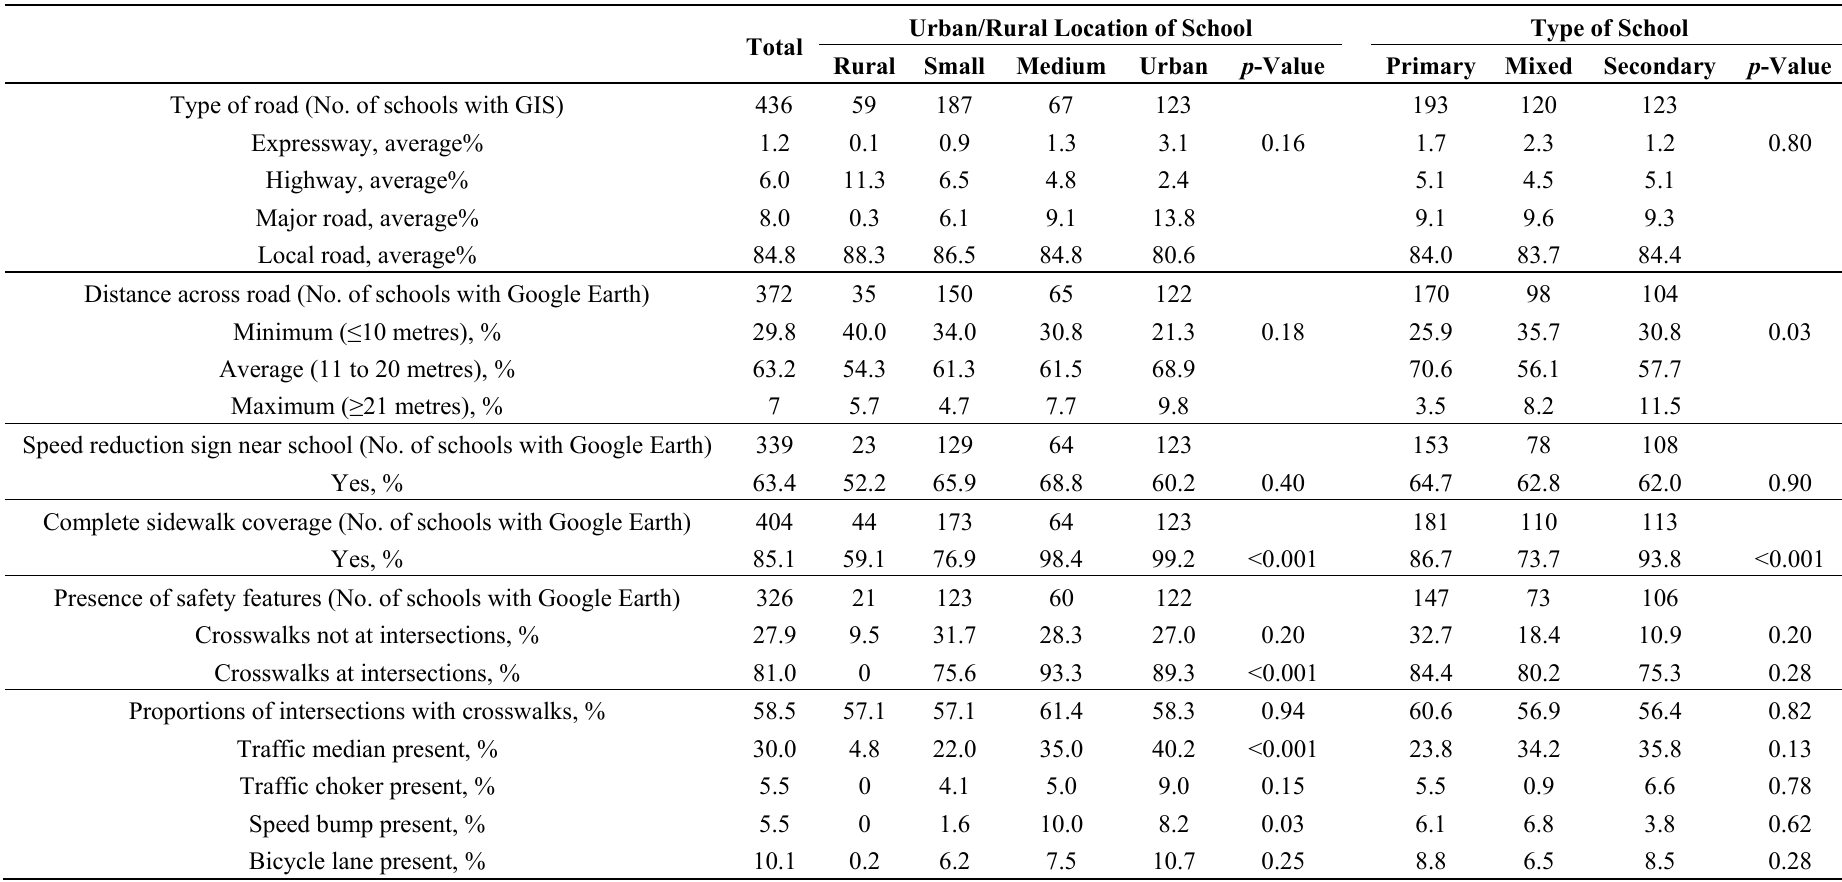
Table 1. Presence of pedestrian and cycling safety features in environments surrounding Canadian schools. Urban/Rural Location of School Type of School Total Rural Small Medium Urban p -Value Primary Mixed p -Value Type of road (No. of schools with